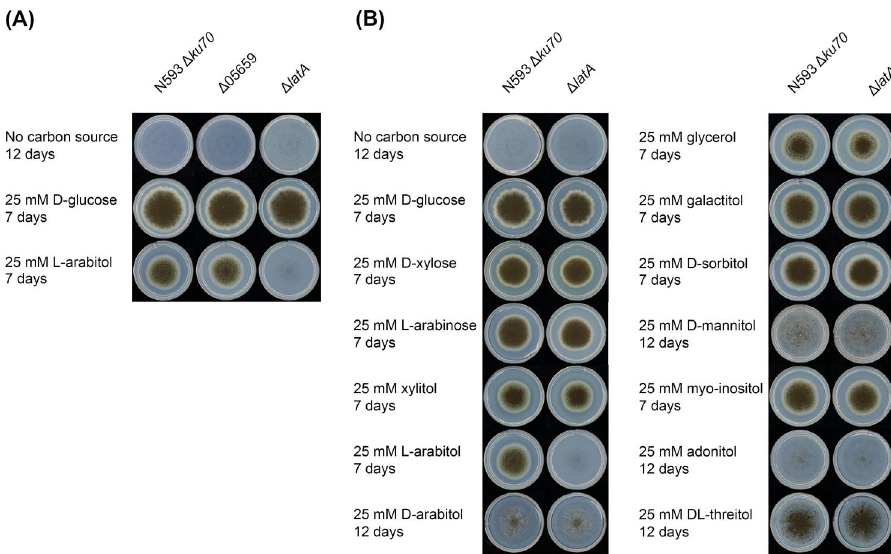
Figure 2. Phenotypic analysis of mutant and reference strains. ( A ) Growth profiling of the A. niger reference strain N593 Δ ku70 and two single deletion mutants Δ05659 and Δ latA on L -arabitol. ( B ) Growth profiling of the A. niger reference strain N593 Δ ku70 and Δ latA on different sugars and